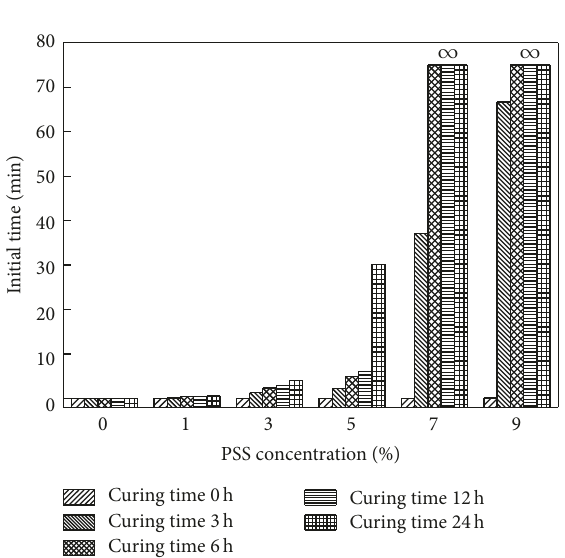
Figure 7: Initial time of running water from bottom outlet.